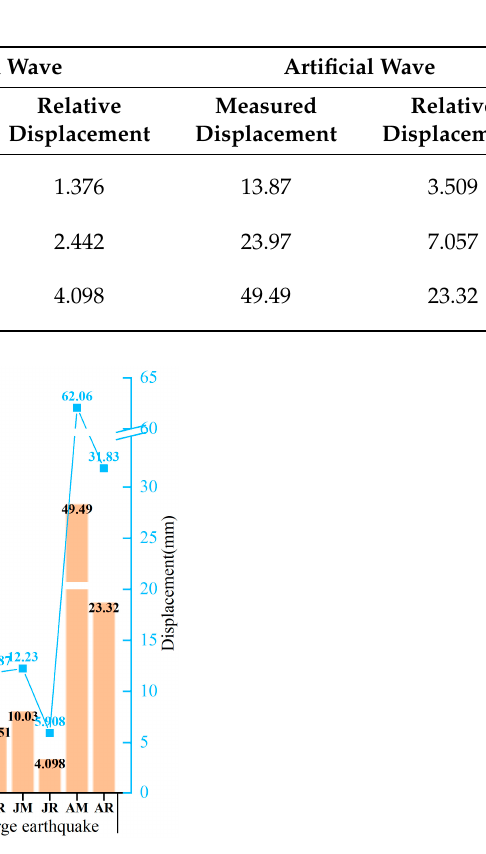
Figure 7. The relative displacements of multiple floors of the Small Wild Goose Pagoda. (Note: in the x-coordinate, the letter E stands for “El-Centro Wave”; the letter J refers to Jiangyou Wave; the letter A stands for “Artificial Wave”; the letter M stands for “Measured displacement”; the letter R stands for “Relative Displacement”.)